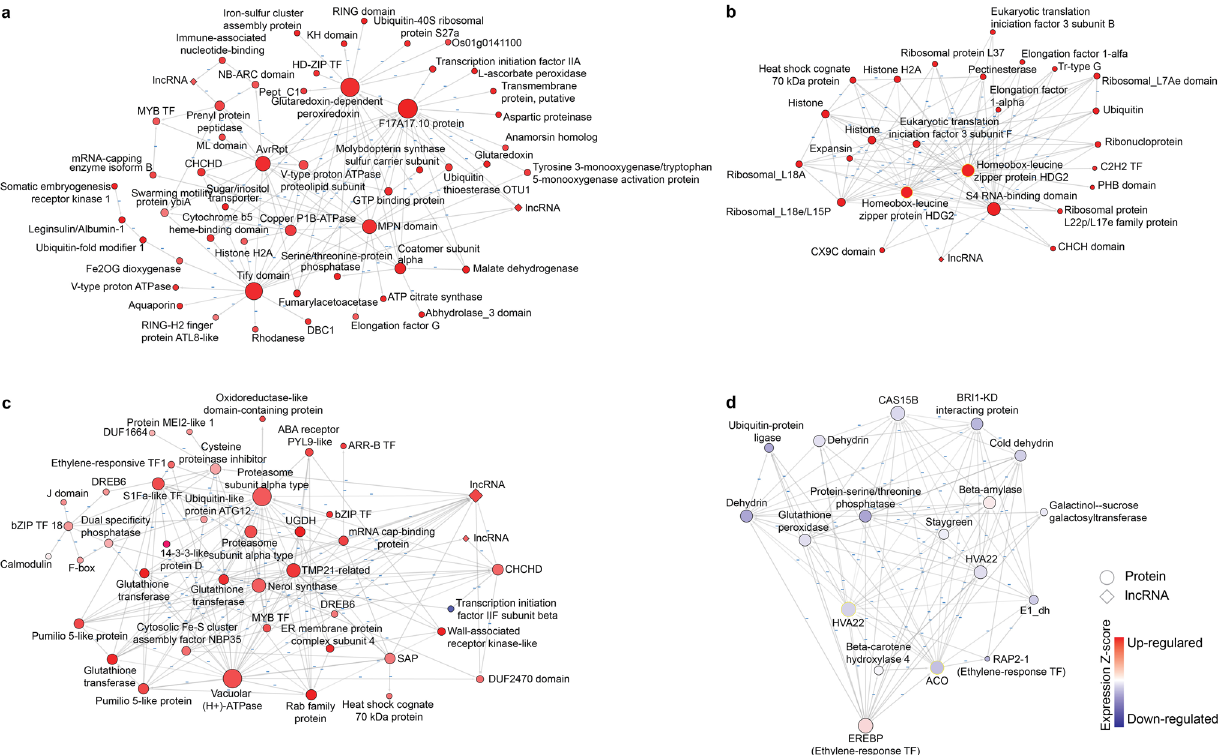
Figure 6. Gene networks in response to salt and drought stresses in tolerant germplasms. ( a ) Sub-network of PI467895-SS. ( b ) Subnetwork of Wilson-DS. ( c ) Sub-network of Saranac-SS. ( d ) Subnetwork of Saranac-DS. Modules of isoforms were exported for weighted correlation network analysis in R package (WGCNA) to obtain Cytoscape keeping hub isoforms, lncRNAs and transcription factors. Red and blue isoforms correspond to upregulated and downregulated isoforms, respectively. Node size is proportional to number of edges (degree), circular shapes correspond isoforms coding proteins and rhombus shapes correspond to lncRNAs, under drought stress (DS), salt stress (SS) and control non-stressed